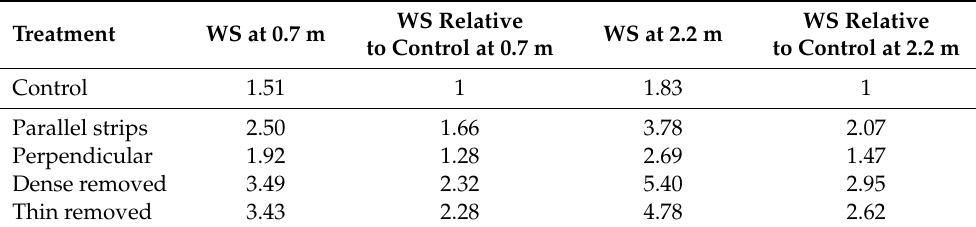
Table 1. Surface wind speeds (WS, km h − 1 ) in di ff ering black spruce treatments under a 25 km h − 1 open wind speed measured at 10 m height. Relative wind speed values are a ratio of treatment to control. WS Relative WS Relative Treatment WS at 0.7 m WS at 2.2 m to Control at 0.7 m to Control at 2.2